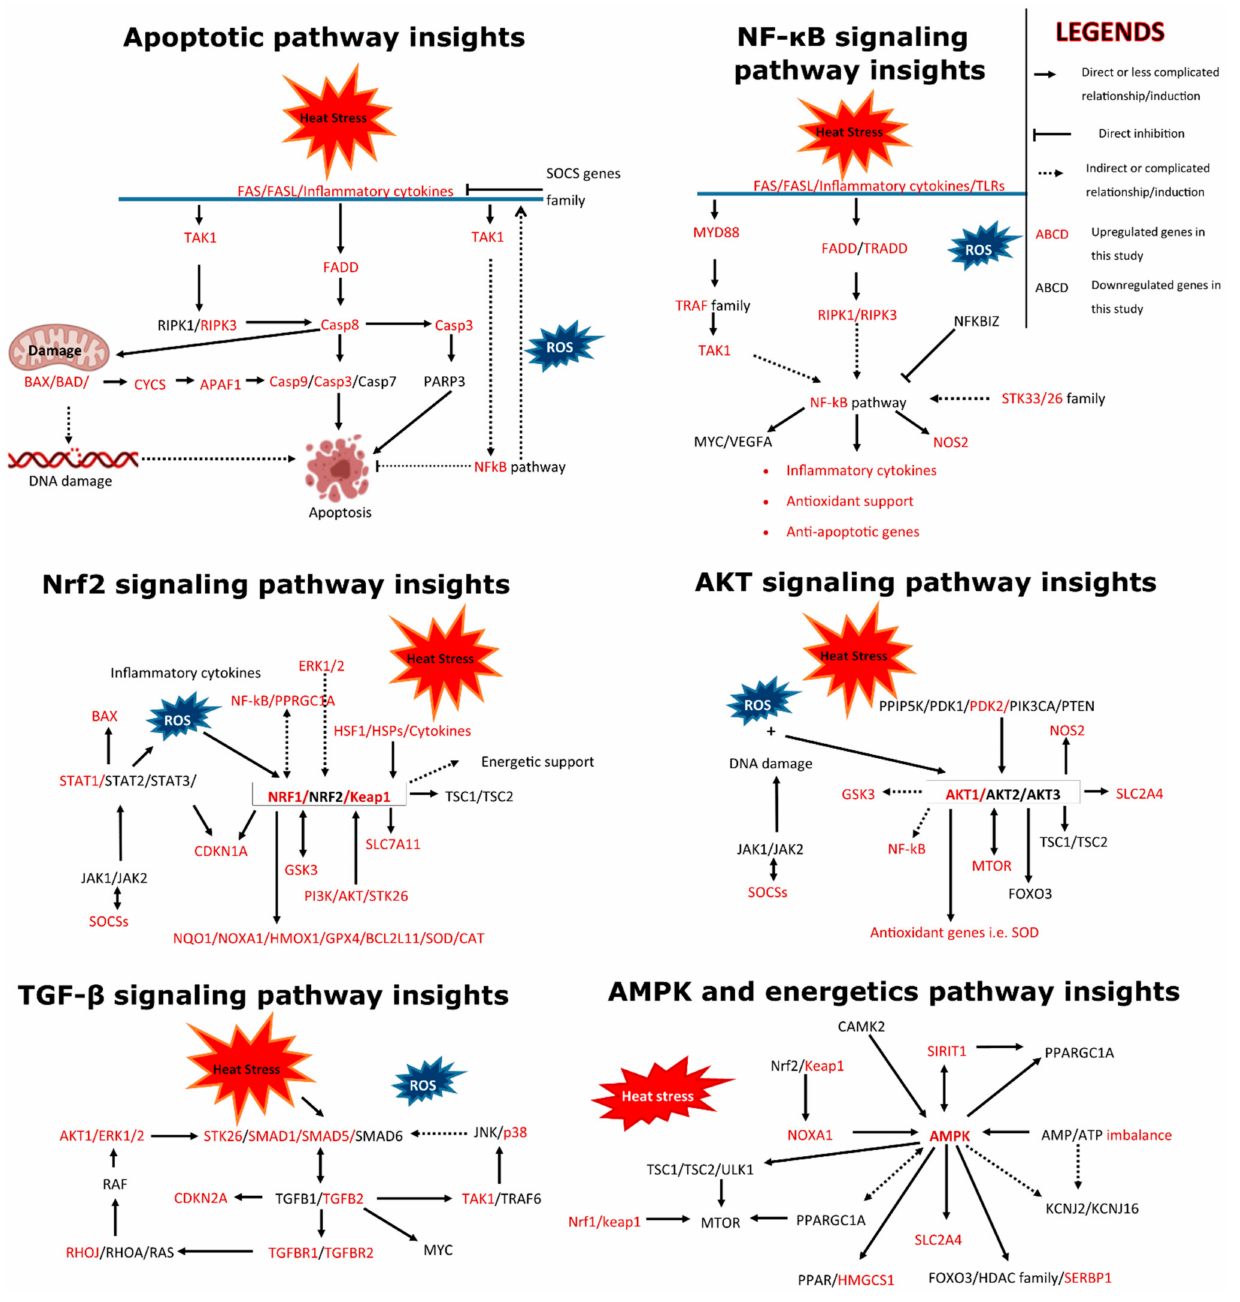
Figure 7. Various important cellular signaling pathways and the genes implicated in these pathways along with the regulation status of these genes in control versus heat-stress treatment of granulosa cells (upregulated genes or gene families are written in red